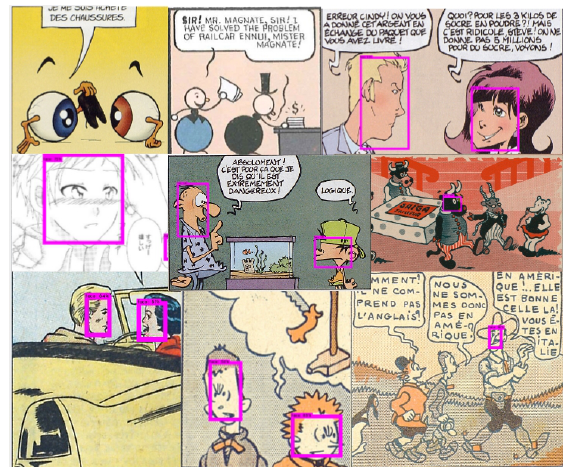
Figure 7. Face detection on eBDtheque using model trained on DCM772.